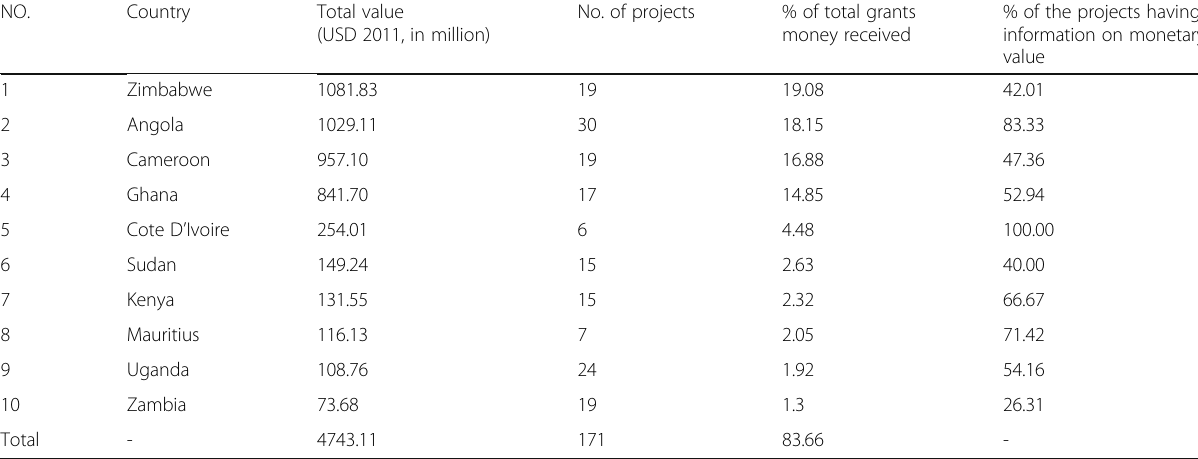
Table 3 Top 10 recipient countries by cumulative total of grants awarded by the Chinese government NO. Country Total value (USD 2011, in